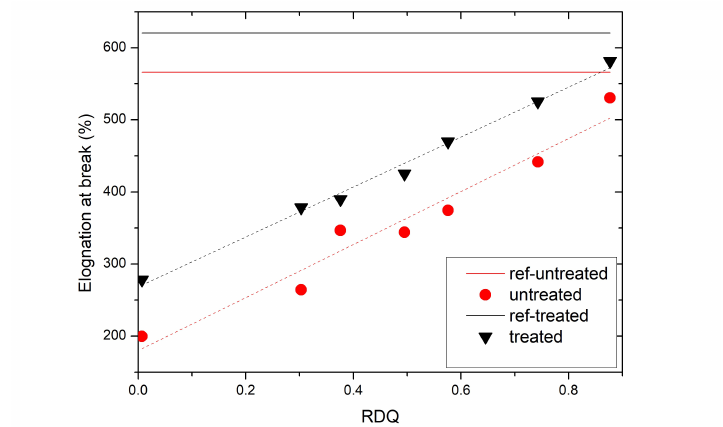
Figure 6. A development of elongation at break of CNT/NBR nanocomposites as a function of relative dispersion quality together with fitted dashed lines. Elongation at break is growing at slope 367% × RDQ in untreated composites and 346% × RDQ in treated composites. Solid lines are representing unfilled NBR elastomer